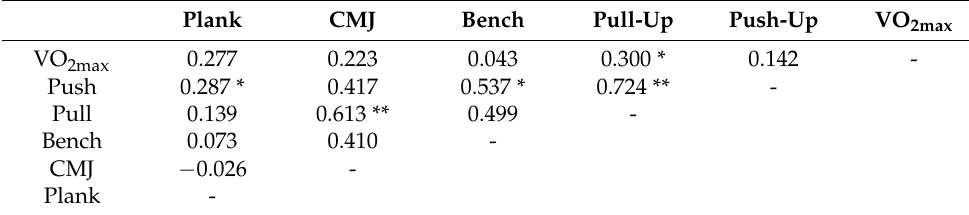
Table 3. Correlation Matrix—Performance.